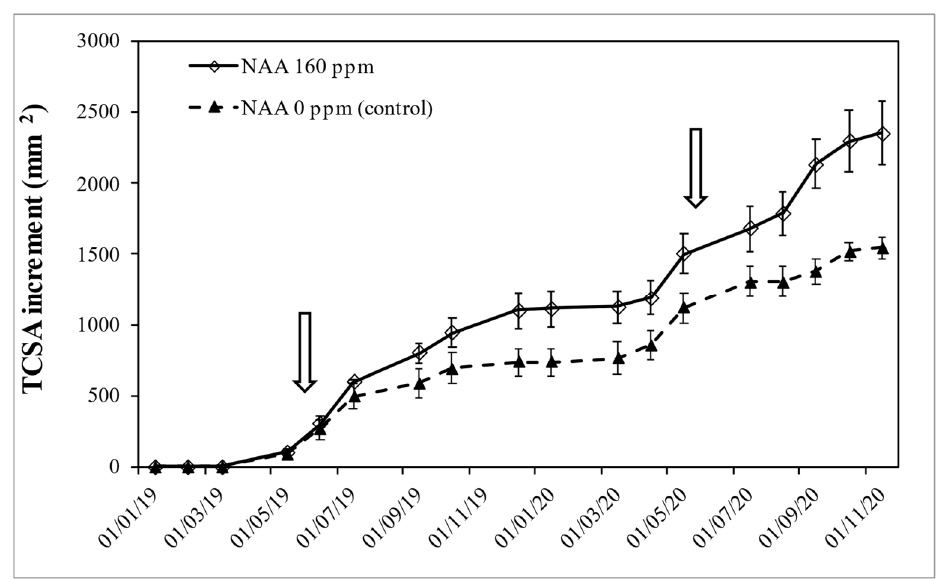
Figure 9. Increment in trunk cross-sectional area (TCSA) over two consecutive years (2019–2020) in control (NAA 0 ppm) and NAA 160 ppm trees in a young intensive olive orchard of the cultivar Moraiolo. The arrows indicate the time of NAA treatments. The bars represent the standard error of 4 replicates per treatment.